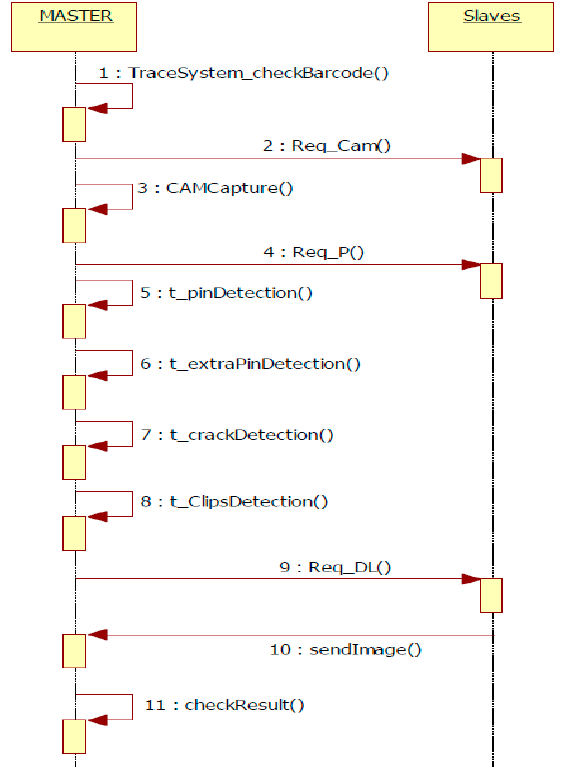
Figure 7. Processing flowchart.